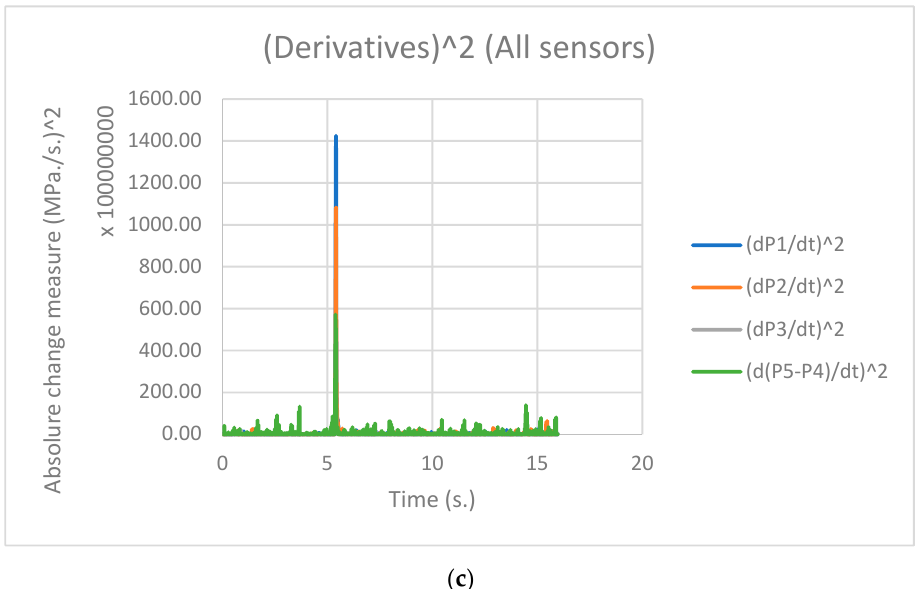
Figure 3. Measured pressures, an example from Run 4:1 ( a ) All measured pressure, ( b ) the in-die pressures alone for clarity, and ( c ) the squared pressure derivatives.